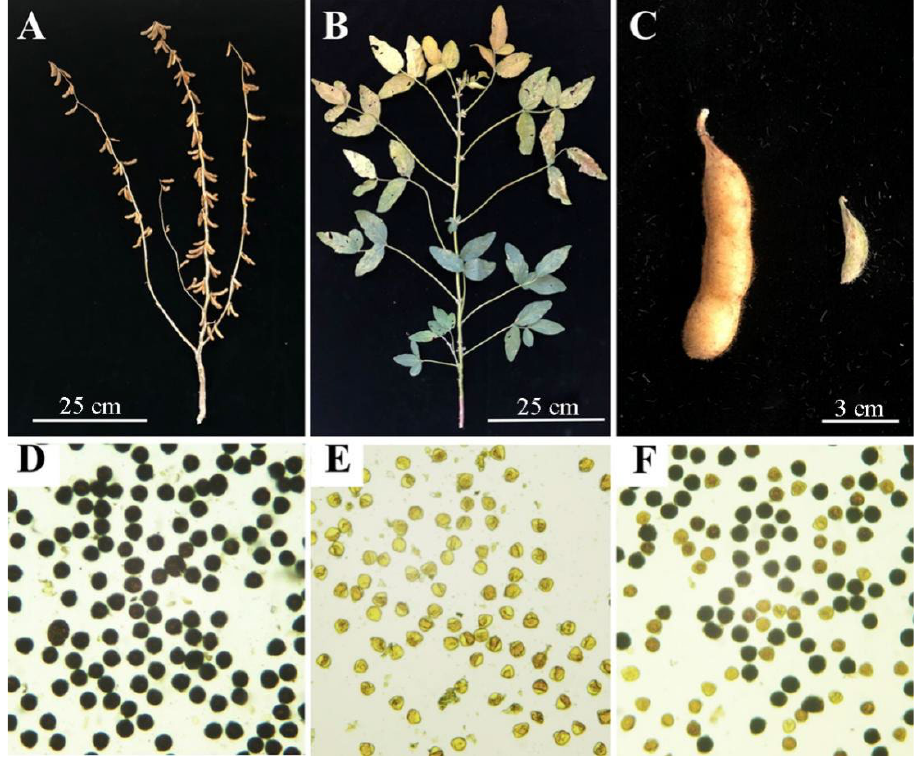
Figure 1. Phenotypic and cytological characterization of the restorer and cytoplasmic male sterile (CMS) lines. ( A ) Restorer line JLR2. Scale bar: 25 cm. ( B ) CMS line JLCMS5A. Scale bar: 25 cm. ( C ) Pods of JLR2 (left) and JLCMS5A (right). Scale bar: 3 cm. ( D – F ) Mature pollen grains of JLR2, JLCMS5A, and F 1 plants stained with I 2 -KI.